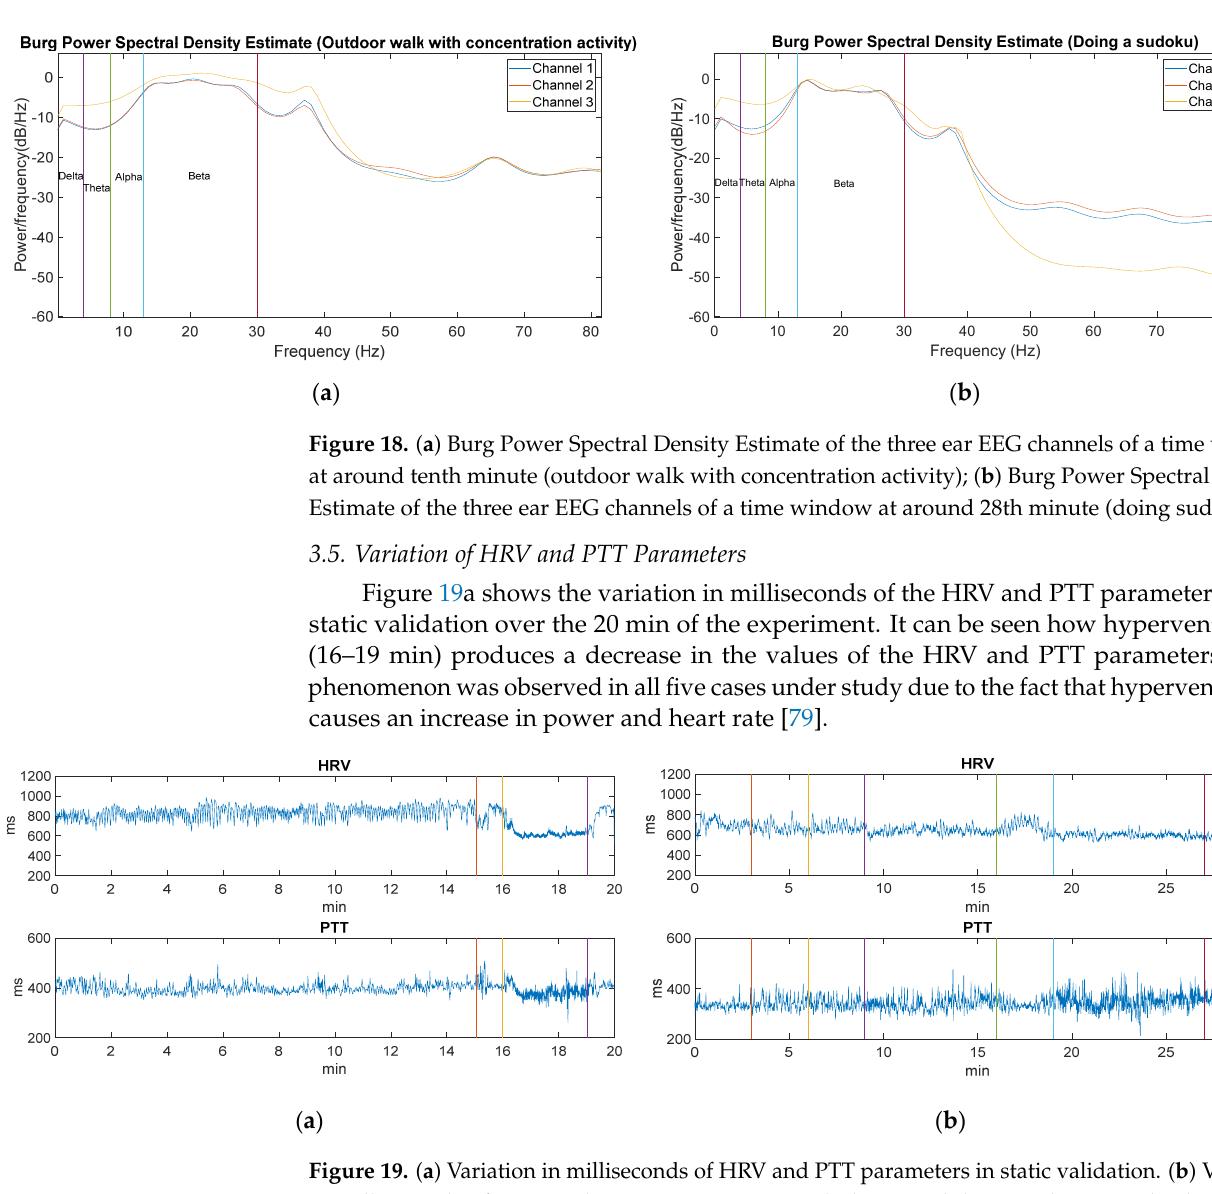
Figure 19. ( a ) Variation in milliseconds of HRV and PTT parameters in static validation. ( b ) Varia ‐ tion in milliseconds of HRV and PTT parameters in ambulatory validation. The vertical colored lines separate the periods of the different activities developed during the experimentation.